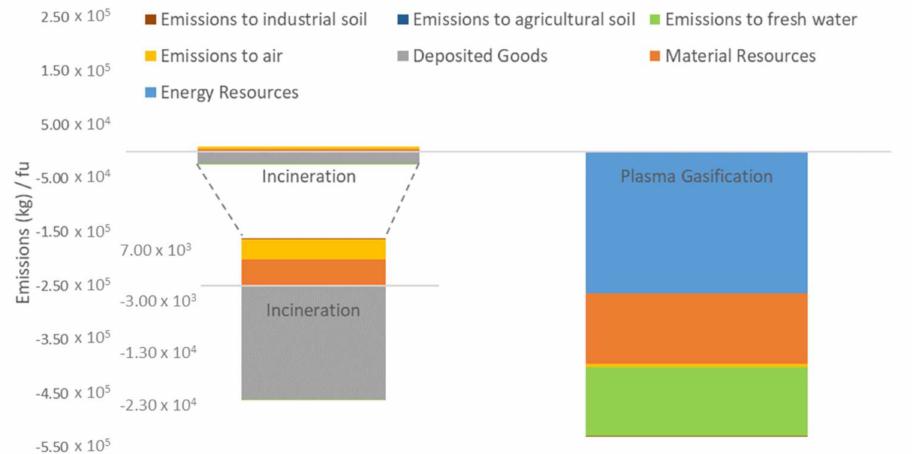
Figure 6. Environmental overall performance comparison between incineration and two-stage plasma gasification of one ton of